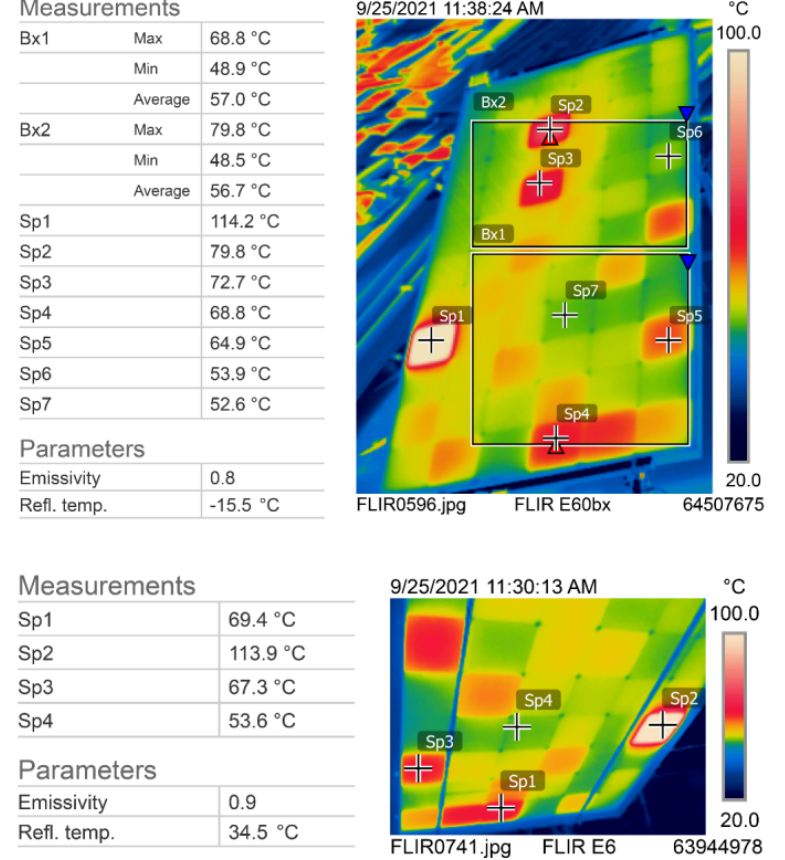
Figure 21. Thermographic analysis of the frontside ( up ) and backside ( down ) of module number 4.